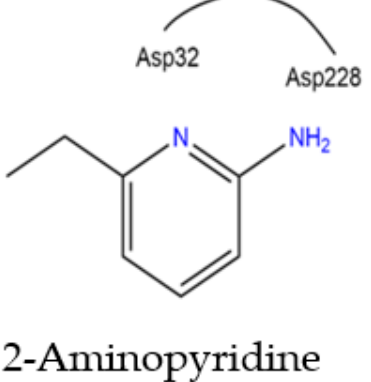
Figure 8. Binding of Asp32 and Asp228 to the 2-aminopyridine moiety.